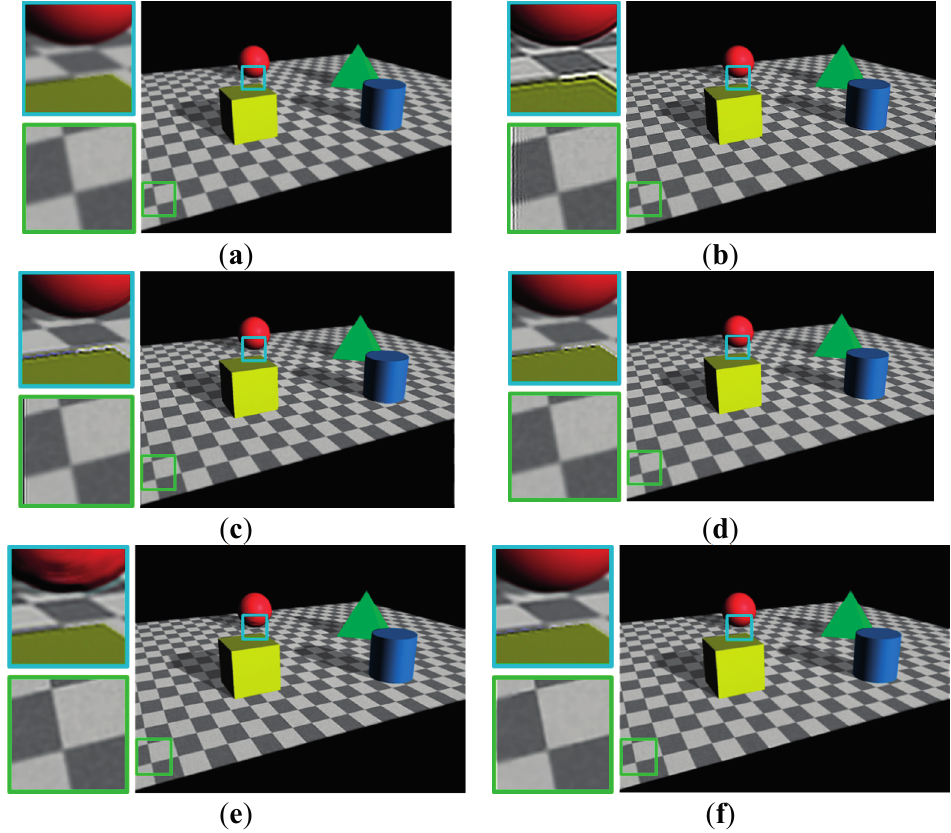
Figure 11. Comparison of different restoration algorithms using another synthetic image generated by a commercial three-dimensional computer graphics software; ( a ) the input image; ( b ) the restored image by the Dong’s method [24] (PSNR = 22.62, MSSIM = 0.94); ( c ) the restored image by the Yang’s method [25] (PSNR = 29.00, MSSIM = 0.98); ( d ) the restored image by the Xu’s method [12] (PSNR = 26.17, MSSIM = 0.96); ( e ) the restored image by the Shen’s method [14] (PSNR = 30.21, MSSIM = 0.98); and ( f ) the restored image by the proposed method (PSNR = 35.44, MSSIM =